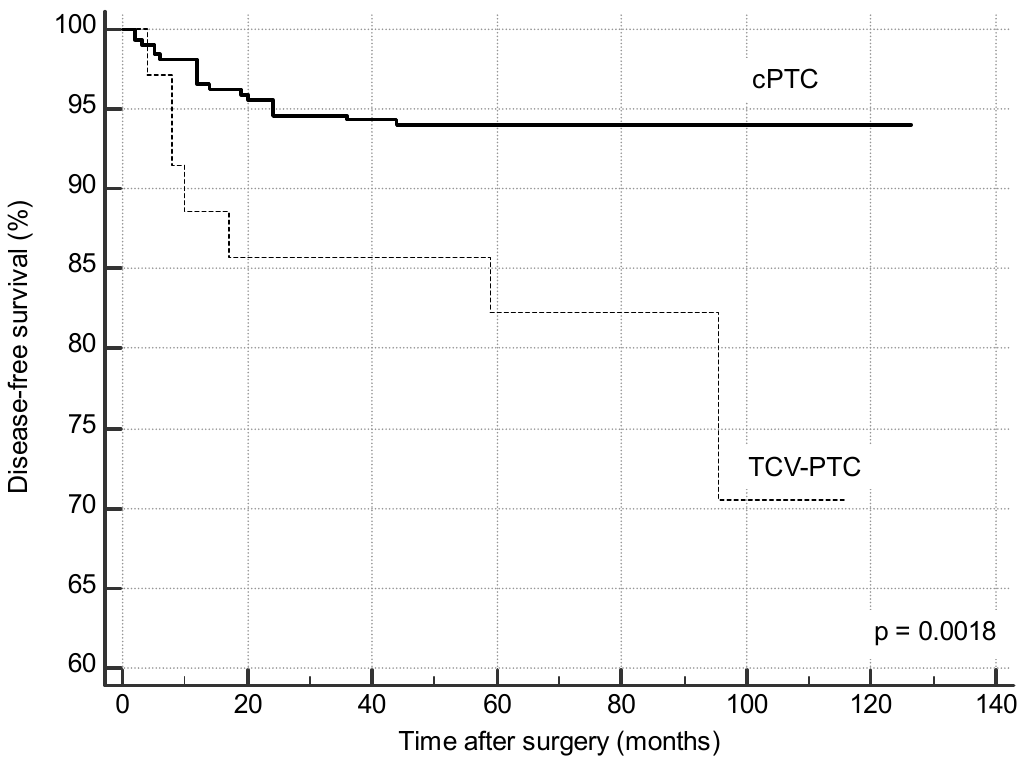
Figure 1. Disease-free survival (Kaplan–Meier method) .